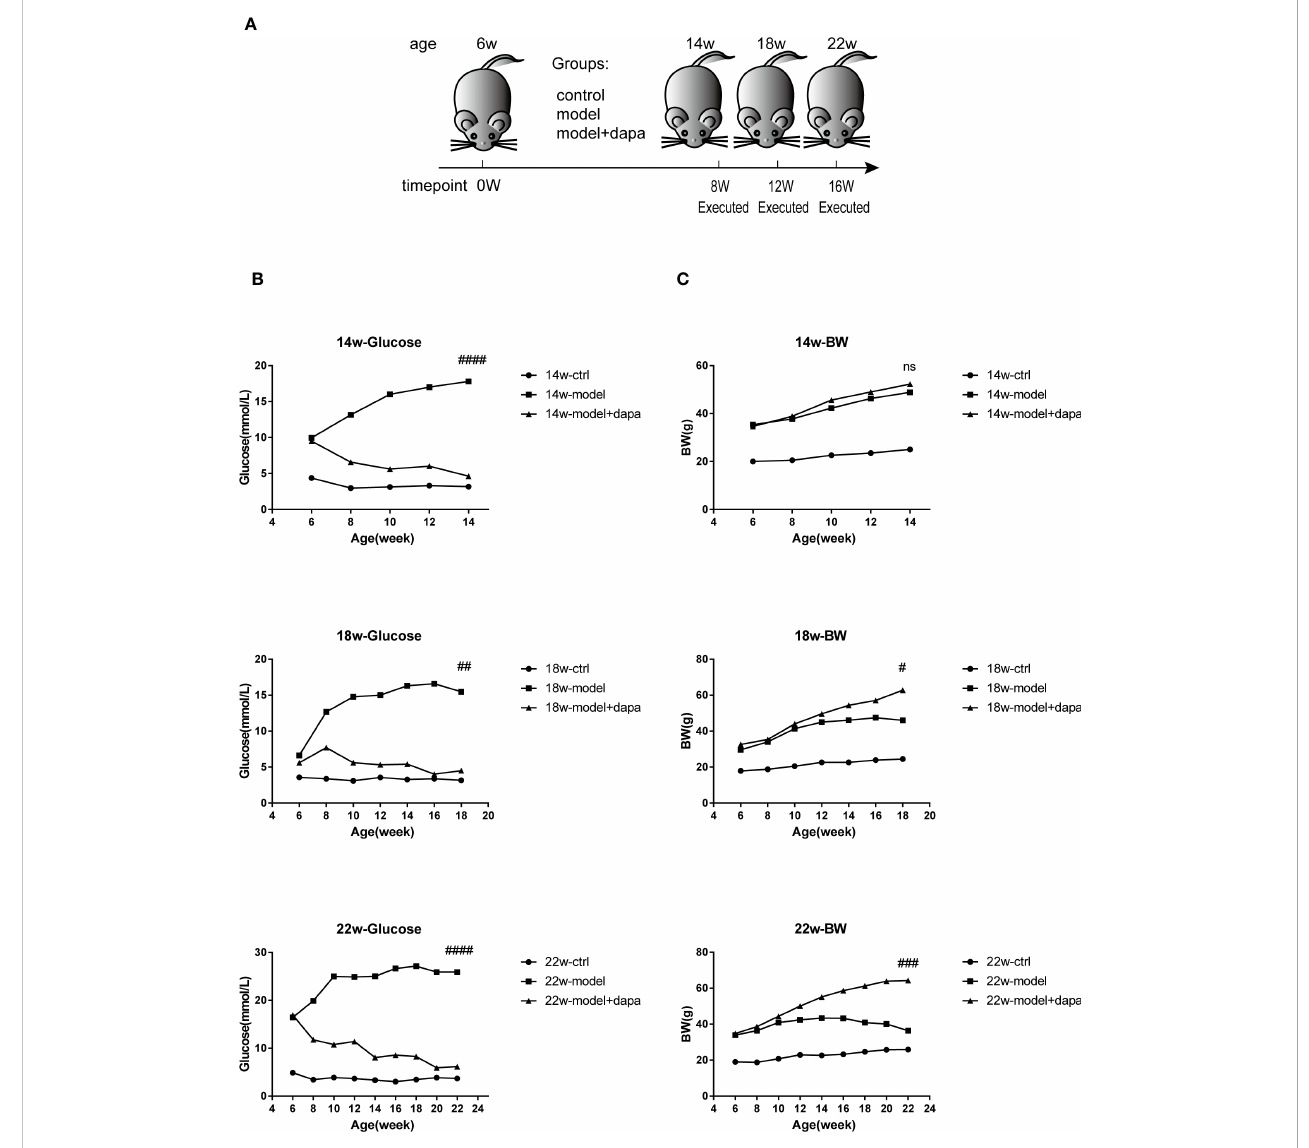
FIGURE 1 DAPA effectively controls fasting blood glucose and body weight in db/db mce. (A) the Experimental design for mice. Brie fl y, six-week-old male nondiabetic db/m and diabetic db/db mice were randomly divided into three group (db/m + physiological saline mice (ctrl group), db/db + physiological saline mice (model group), and db/db model mice + DAPA (model +DAPA group)) and administrated by oral gavage once daily with physiological saline or 1.0 mg/kg/day DAPA, fi nally executed respectively at 14w (14 weeks), 18w (18 weeks), and 22w(22 weeks). (B) Fasted blood glucose levels respectively from 6w to 14w, 18w, and 22w. (C) Changes in body weight respectively from 6w to 14w, 18w, and 22w. Statistical signi fi cance was calculated using ANOVA with Tukey's test. N=4/group. # p < 0.05, ## p < 0.01, ### p < 0.001, #### p < 0.0001, ns, not signi fi cant for model group vs model + DAPA group at the same time point. ctrl: the control